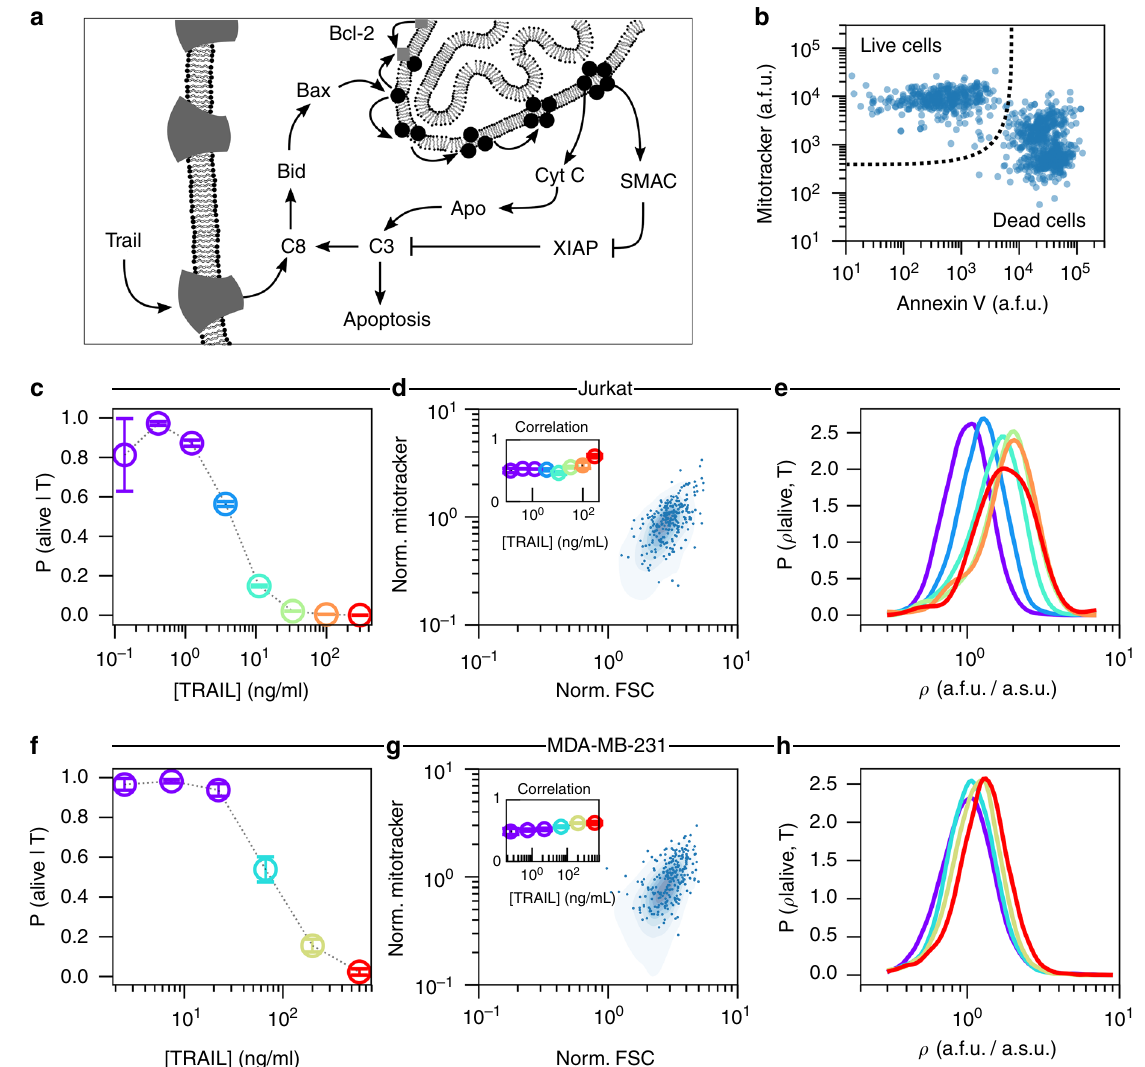
Fig. 1 TRAIL administration enriches for cells with high density of mitochondria. a An overview of TRAIL-induced apoptosis. b Flow cytometry measurements (FCM) of mitochondria (MitoTracker Deep Red) and phosphatidylserine (FITC-conjugated Annexin V) in Jurkat cells. Complete fl ow cytometry gating strategy can be seen in Supplementary Fig. 1. The fractional response of Jurkat cells ( c ) to TRAIL. Each color corresponds to a unique fractional response to a speci fi c TRAIL dose. Cell size measurements (FSC-A) in Jurkat cells ( d ) are correlated with mitochondria abundance (MitoTracker Deep Red). The inset shows that the Pearson correlation marginally changes for each TRAIL dose. The probability density of mitochondria density ( ρ ) for each dose of TRAIL that elicits a unique response in Jurkat cells ( e ). The fractional response of MDA-MB-231 cells to TRAIL ( f ). Cell size measurements (FSC-A) in MDA-MB-231 cell ( g ) are correlated with mitochondria abundance (MitoTracker Deep Red). The inset shows that the Pearson correlation marginally changes for each TRAIL dose. The probability density of mitochondria density ( ρ ) for each dose of TRAIL that elicits a unique response in MDA- MB-231 cells ( h ). In ( e ) and ( h ) the single-cell measurements from each of the lowest three doses of TRAIL are aggregated prior to probability density estimation (Violet). Visual inspection of the respective dose response curves suggests that these three doses of TRAIL are effectively identical. Data presented with error bars represent the mean ± one standard error of the mean over triplicate